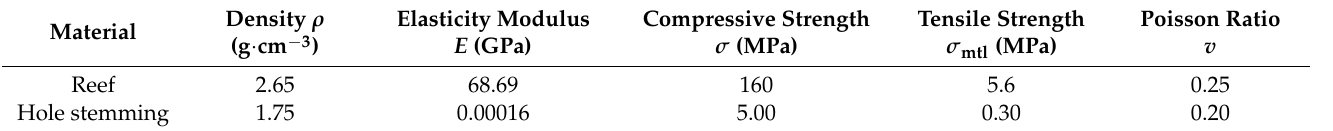
Table 3. Physical parameters of the reef and plug.